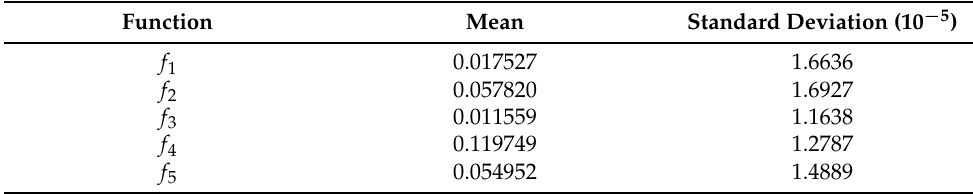
Table 3. Mean and standard deviation of the results from PSO